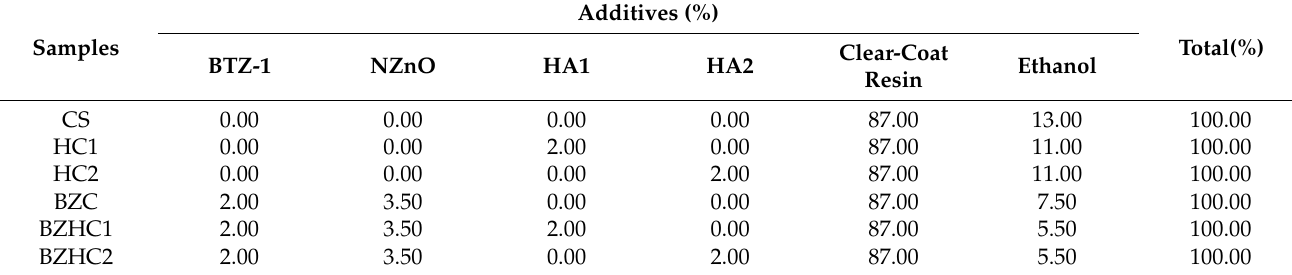
Table 2. Formulations of